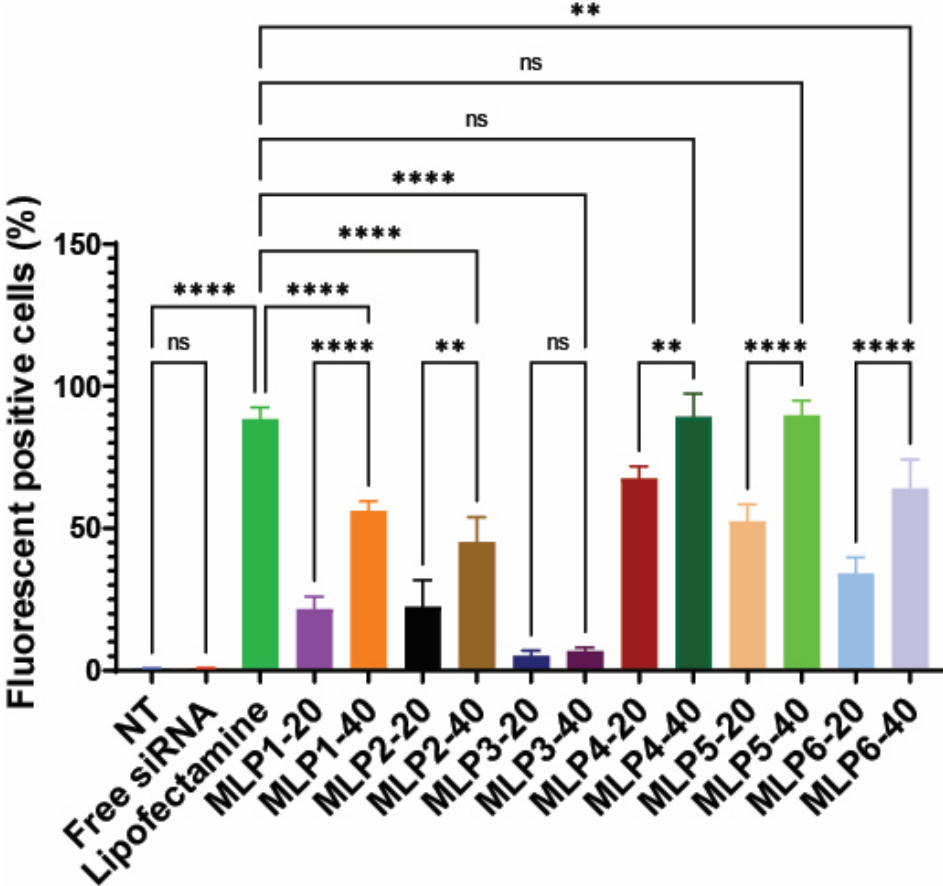
Figure 7. Cellular uptake of Alexa Fluor 488 ‐ labeled siRNA in MDA ‐ MB ‐ 231 cells in the presence of peptides (MLP1–MLP6) and Lipofectamine. The number adjacent to the peptide code indicates the N/P ratio. The concentrations of siRNA and Lipofectamine for all the groups were 36 nM and 1 μ g/mL, respectively (incubation time: 24 h). Bars represent the mean value (n = 3), and the error bars represent standard deviations. ns = non ‐ significant ( p ‐ value > 0.05), ** p ‐ value < 0.001, and **** p ‐ value < 0.0001.